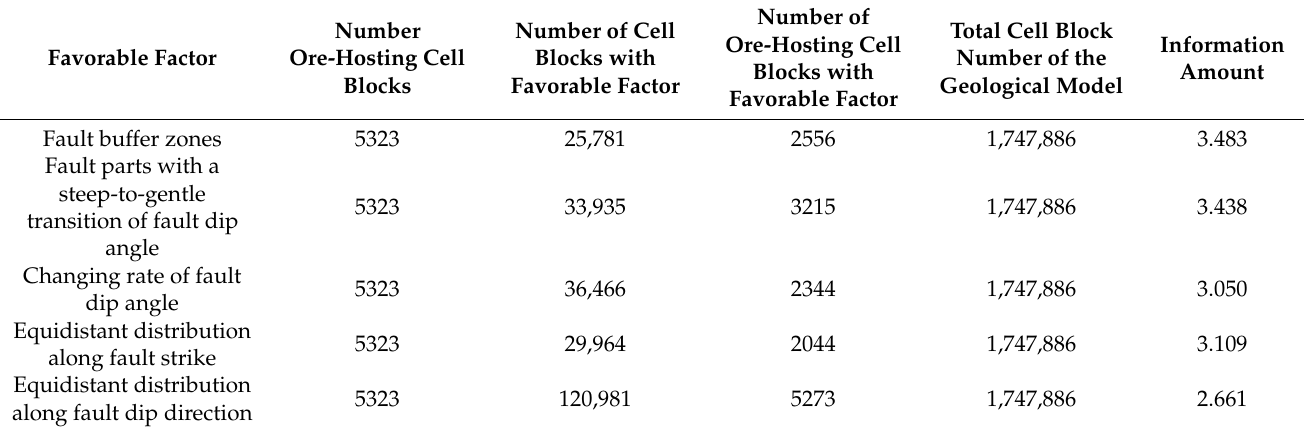
Table 4. Calculated results of prospecting information amounts of the Sanshandao fault.